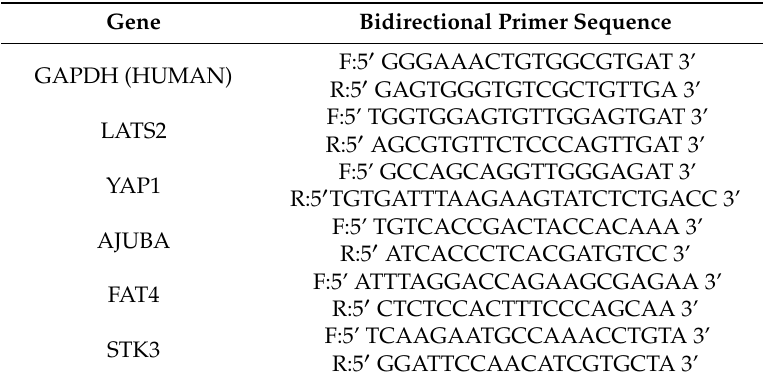
Table 3. The primers used for real-time PCR